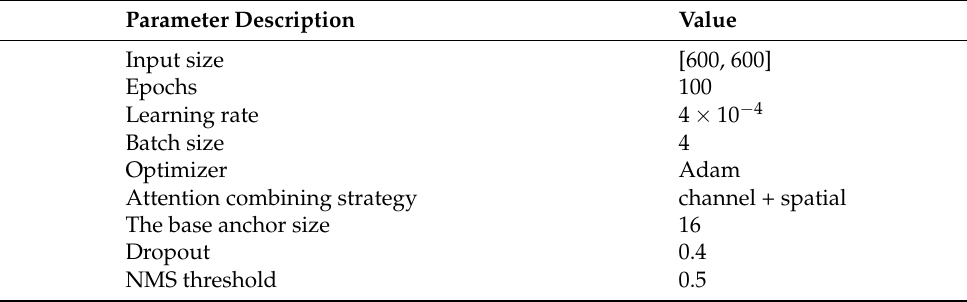
Figure 9. The relationship between diagnosis accuracy and ( a ) base anchor size ( b ) attention combin- ing strategy. Table 2. Experimental parameters of faults diagnosis for rolling